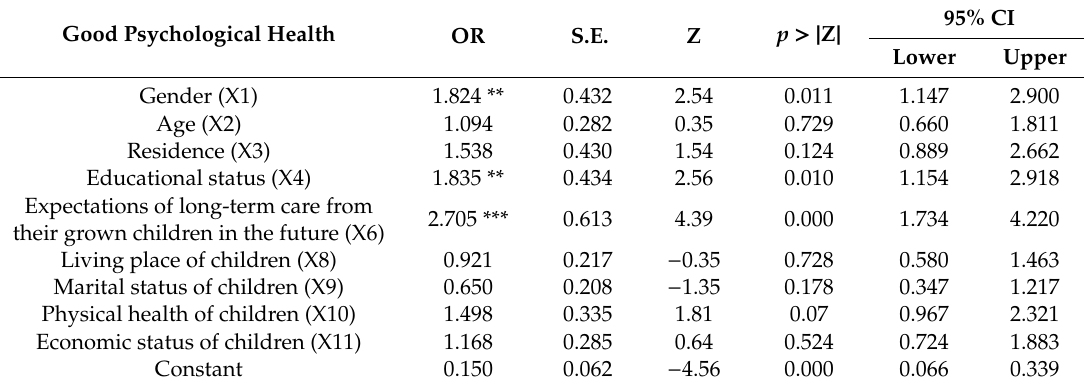
Table 4. Logistic regression results in the third step.